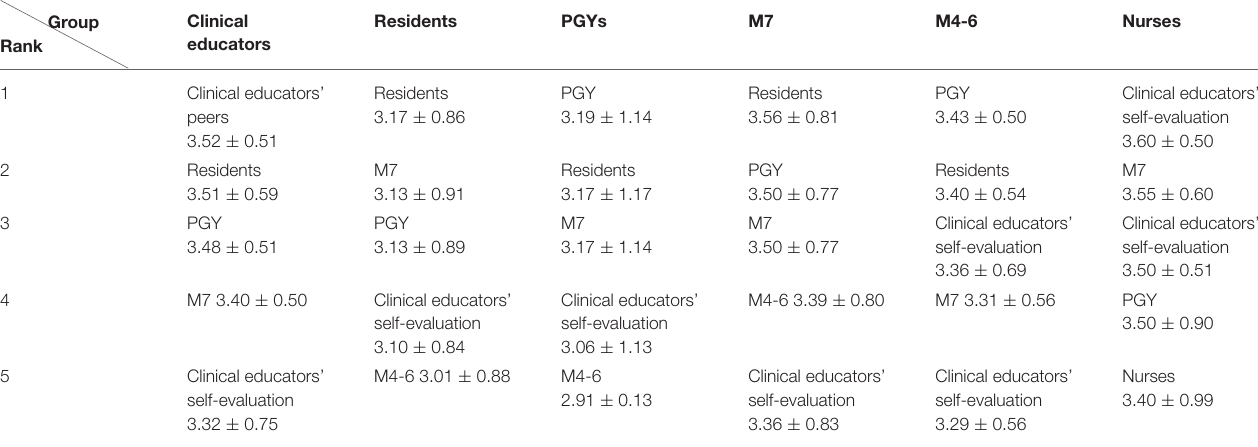
TABLE 4 | The top five stakeholder groups (of 10) rated by respondent groups for evaluating clinical educators.